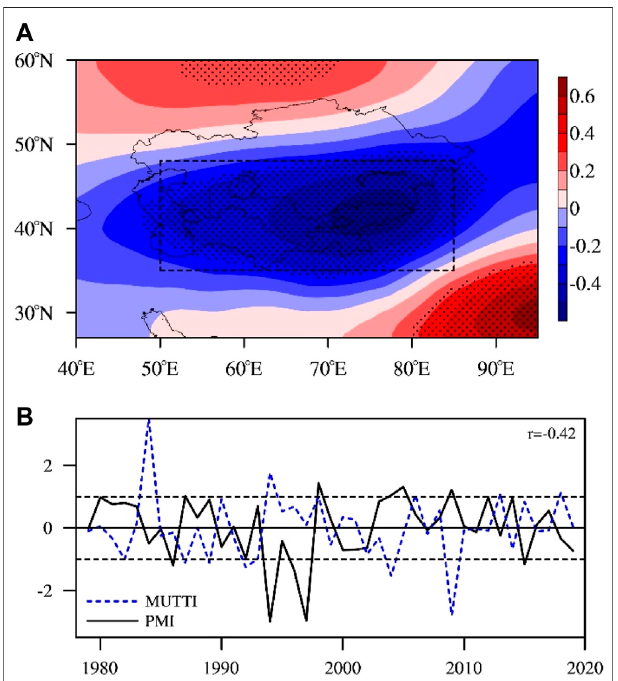
FIGURE 8 | (A) Distribution of the correlation coef fi cient between the TP monsoon index and the mid-upper tropospheric temperature. (B) Time series of the TP monsoon index and the mid-upper tropospheric temperature index (MUTTI). The rectangular lines in (A) indicate the regions selected for the calculation of MUTTI, and the dotted area in (A) shows the area that passed the 90% con fi dence level student ’ s t-test.